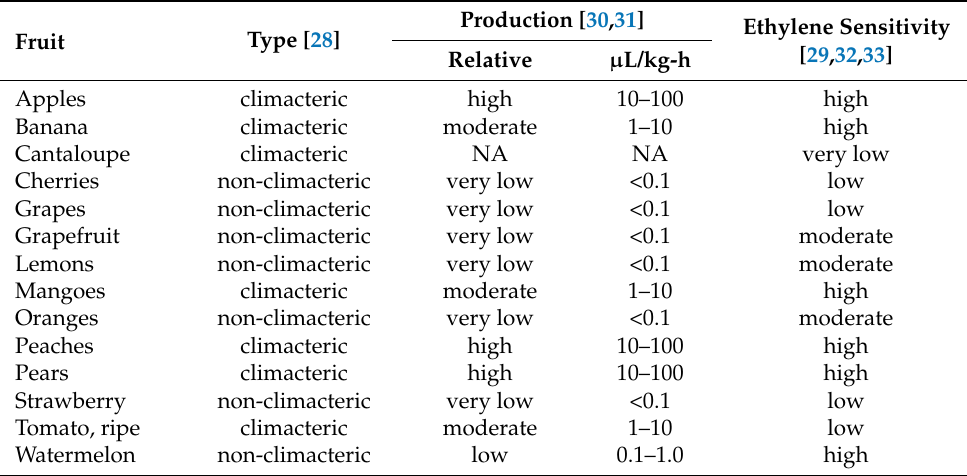
Table 3. Ethylene Production and Sensitivity in Fruit. NA: not available. Production [30,31] Ethylene Sensitivity Fruit Type [28] [29,32,33]Relative µ L/kg-h Apples climacteric high 10–100 high Banana climacteric moderate 1–10 high Cantaloupe climacteric NA NA very low Cherries non-climacteric very low <0.1 low Grapes non-climacteric very low <0.1 low Grapefruit non-climacteric very low <0.1 moderate Lemons non-climacteric very low <0.1 moderate Mangoes climacteric moderate 1–10 high Oranges non-climacteric very low <0.1 moderate Peaches climacteric high Pears climacteric Strawberry Tomato, ripe climacteric moderate Watermelon